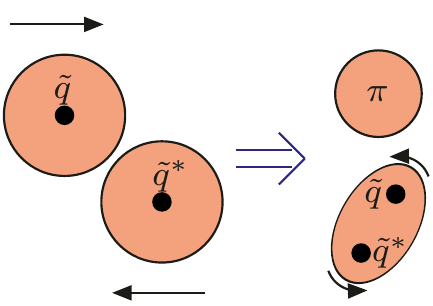
Figure 1. Schematic picture of non-perturbative